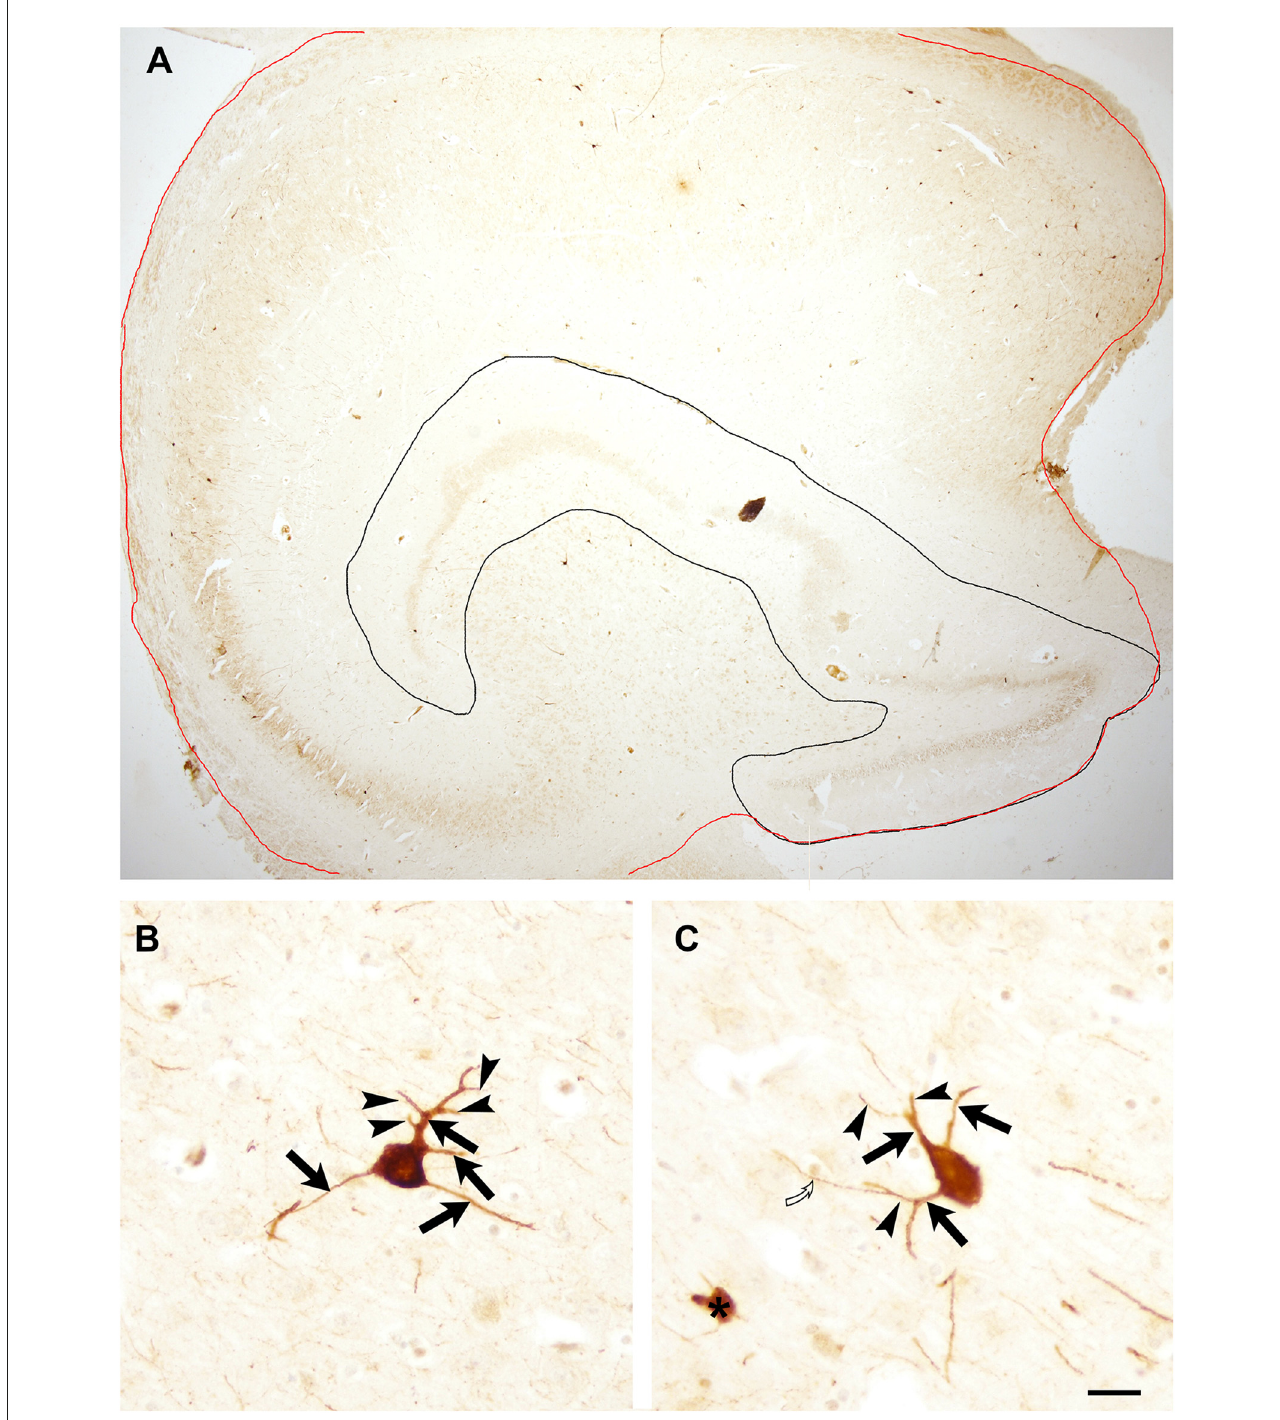
FIGURE1 (A) Low magnification photomicrograph of the entire hippocampal formation of an 11 years old child to illustrate areas used for quantification. The red line outlines the hippocampal formation, black line encircles the dentate gyrus. Both areas were measured with iTEM software. The area of Ammon’s horn was determined following the subtraction of the dentate gyrus’ area from the area of the entire hippocampal formation. Panels (B) and (C) illustrate PV-immunoreactive neurons in an 11-year-old child’s section with several primary and secondary dendrites. Arrows point to primary dendrites, arrowhead indicates secondary dendrites. Open curved arrow points to a tertiary dendrite that was not included in the quantification. Asterisk indicates a PV-immunoreactive profile that was excluded from the quantification of immunopositive neurons. Scale bar = 500 µ m in (A) and 25 µ m in (B) and (C) .